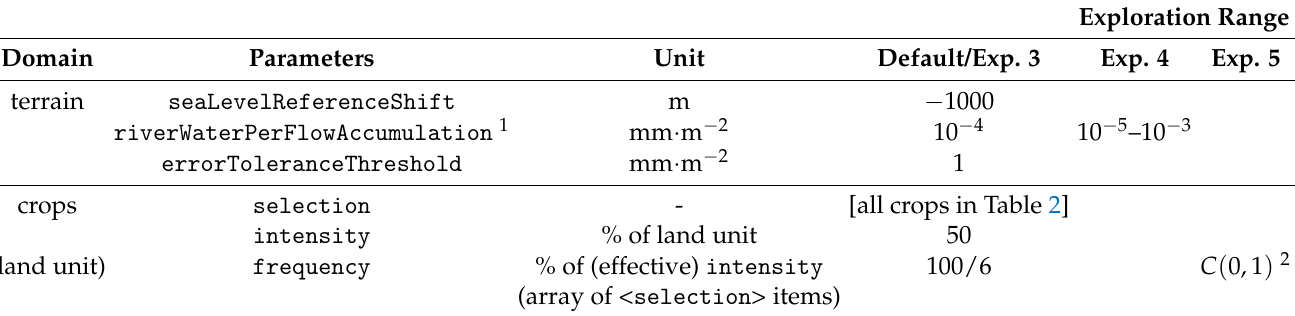
Table 5. Land crop model specific parameters’ values used in experiments 3, 4, and